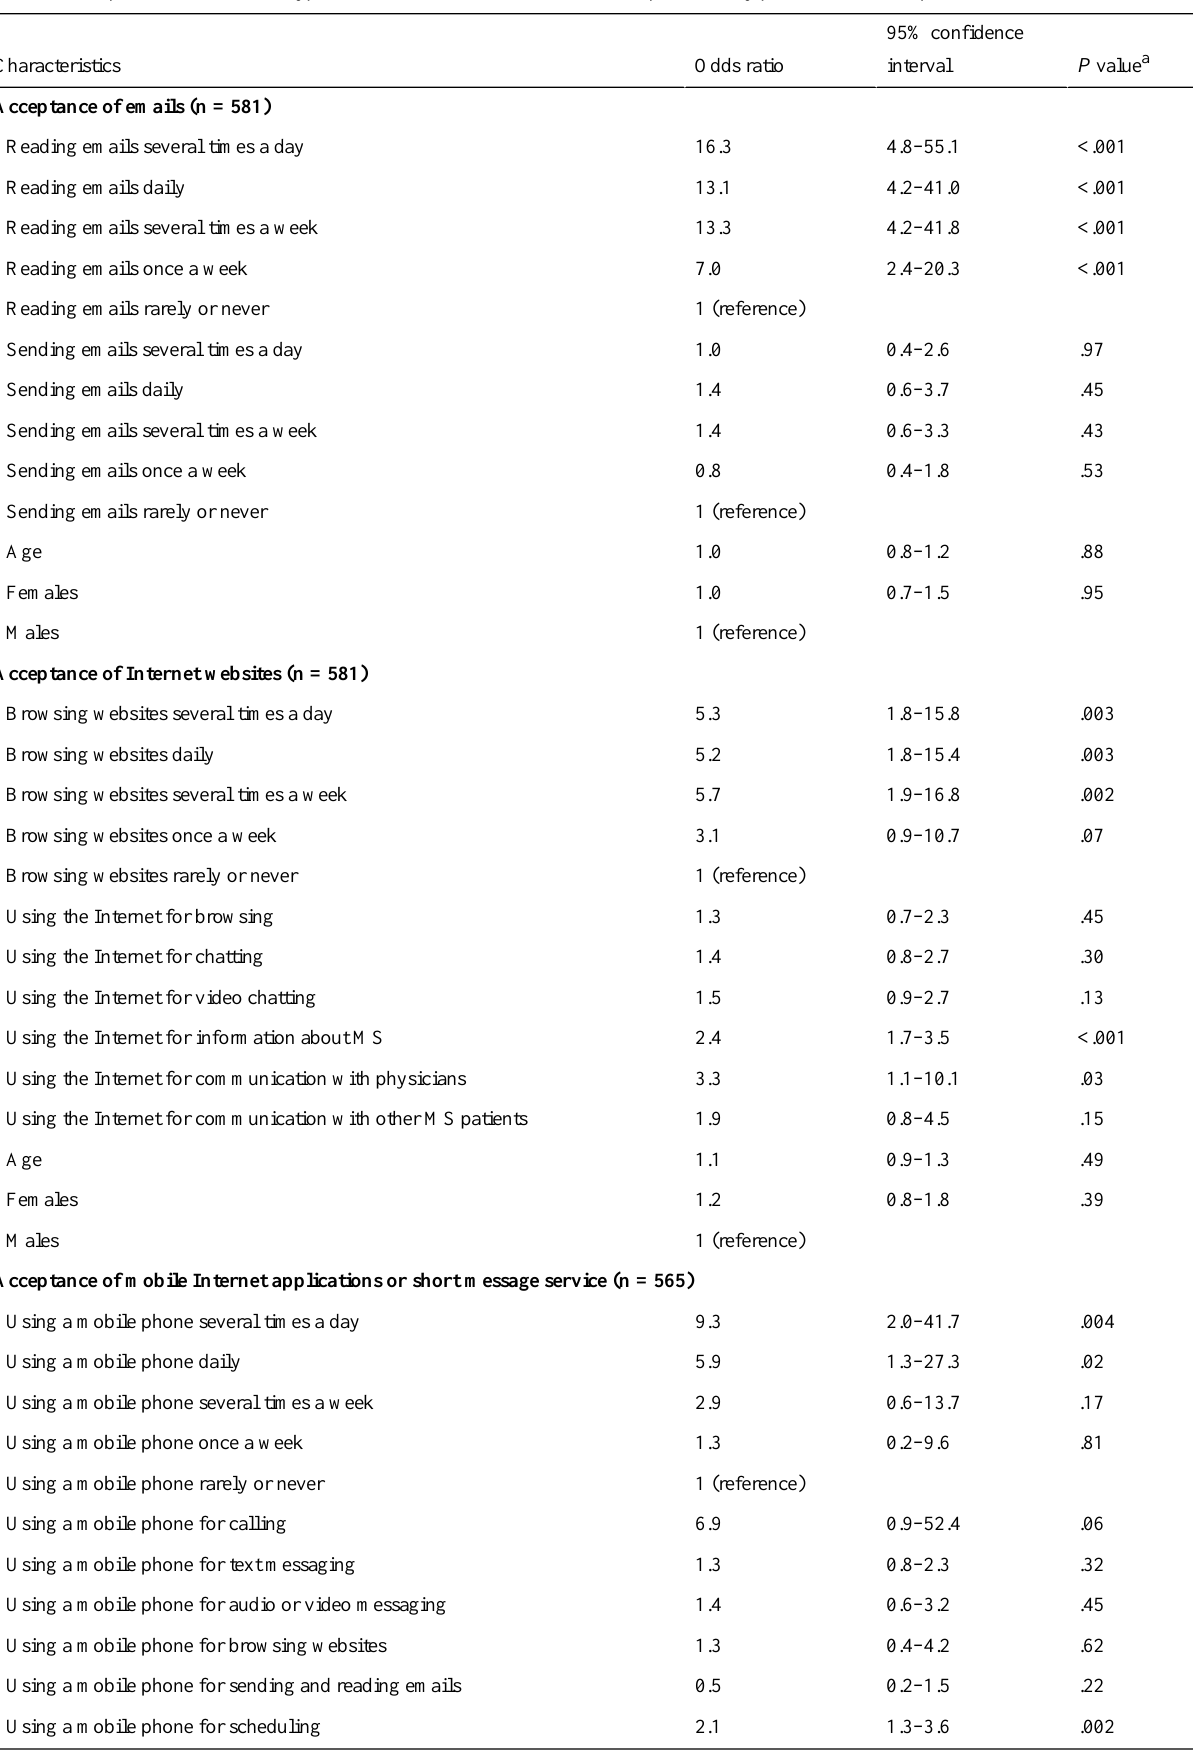
Table 5. Acceptance of new media types for communication with health care providers by patients with multiple sclerosis